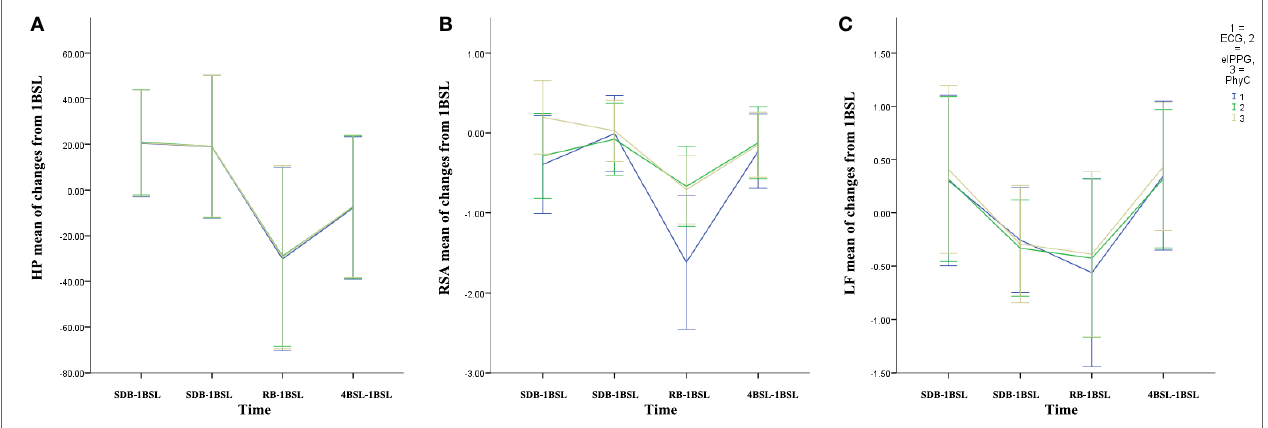
FigUre 10 | Mean of changes from the 1BSL (error bars: ± 2 SE) for the three sensors electrocardiogram (ECG), elPPG, and PhysioCam (PhyC). (a) Heart period (HP). (B) Respiratory sinus arrhythmia (RSA). (c) LF (error bars: ± 2